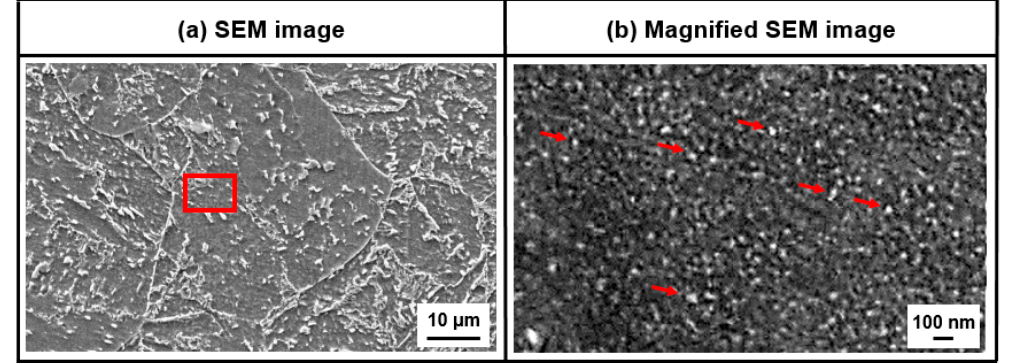
Figure 3. ( a ) Top-sectional SEM image of the P21 steel and ( b ) a few nanometers of Cu particles observed in the magnified SEM image.